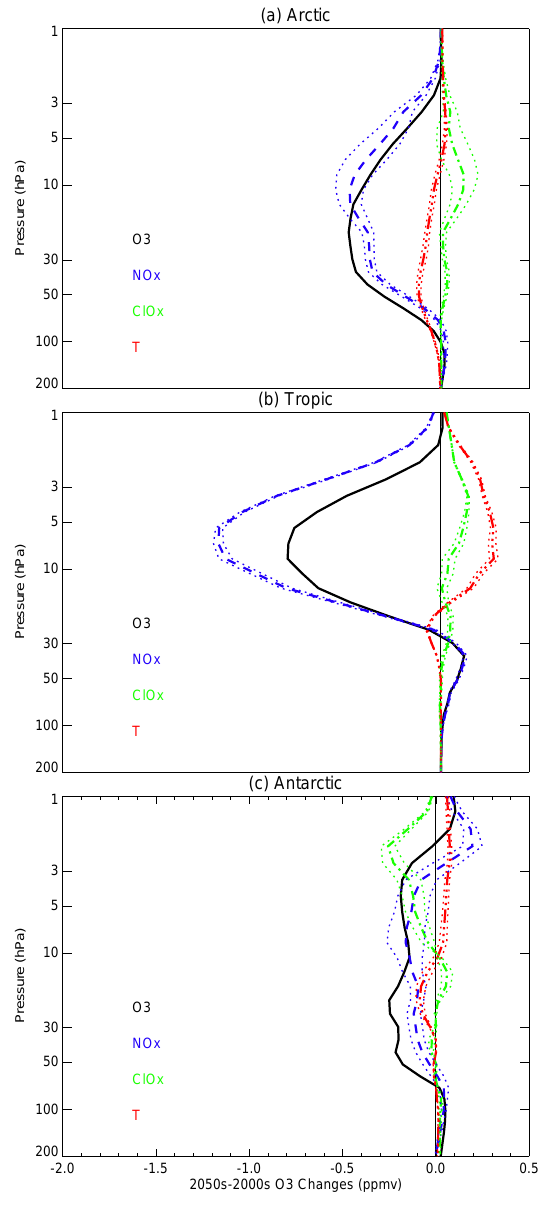
Figure 7. Results of multiple regressions for spatially averaged ozone change ( (cid:49) O 3 = O 3 (E1) − O 3 (E0)) with spatially aver- aged NO x , ClO x and T change. The averaging domains are 90 ◦ N– 70 ◦ N, 22 ◦ N–22 ◦ S, and 70 ◦ S–90 ◦ S. The black thick line shows the changes of (cid:49) O 3 from 2001 to 2050 ( d(cid:49) O 3 ), calculated by a simple linear regression of (cid:49) O 3 with year ( (cid:49) O 3 = a 0 + a 1 × year, d(cid:49) O 3 =a1 × 50). The blue dashed line, green dashed-dotted line and red dashed double point line show the NO x , ClO x and T contribu- = (cid:49) NO x × Coefs tions to (cid:49) O 3 (i.e. d(cid:49) O 3 , NO NO x ), respectively. x The dotted lines indicate the uncertainties for the contributions, which are based on the uncertainties of the regression